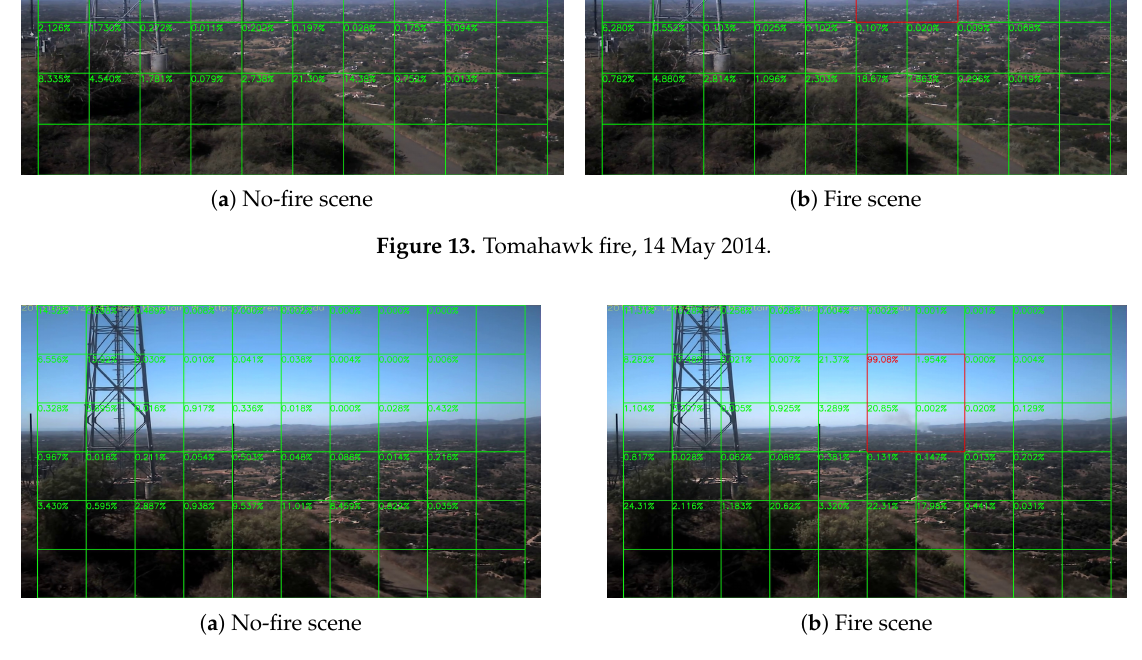
Figure 14. DeLuz fire, 5 October 2013.